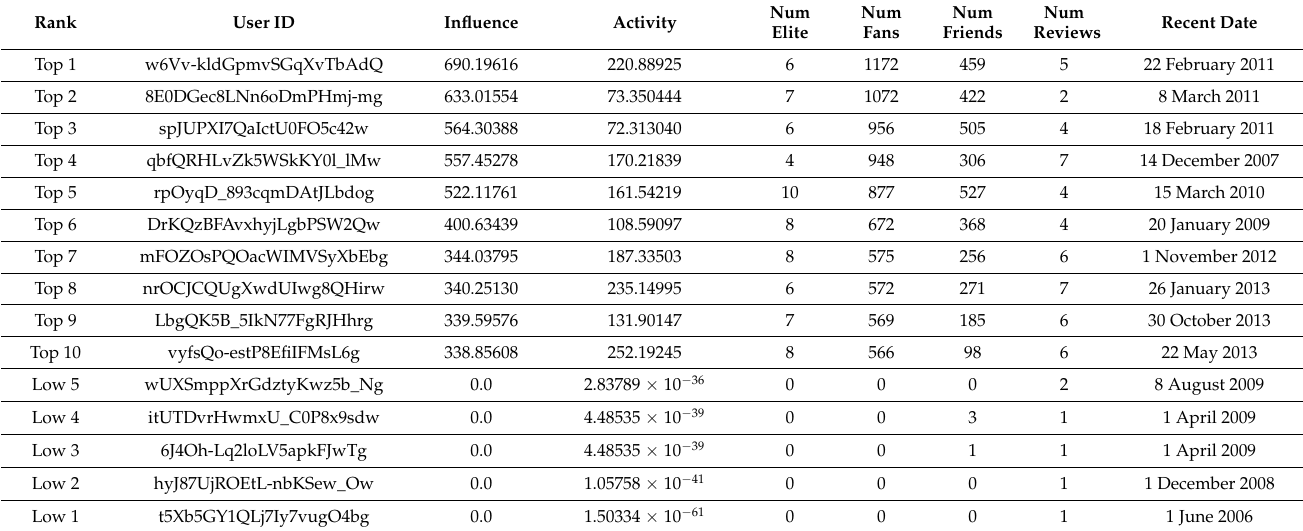
Table 2. Top 10 and lowest 5 influential user